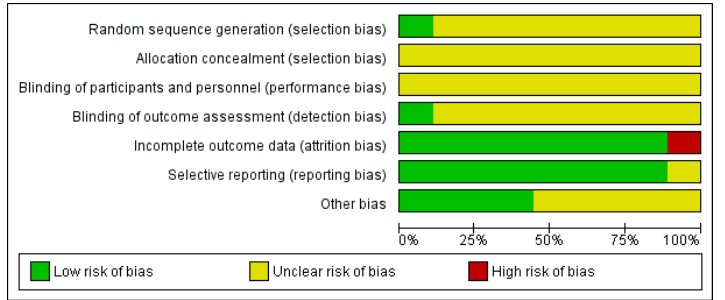
Figure 3. Risk of bias graph: review authors’ judgements about each risk of bias item presented as percentages across all included studies.